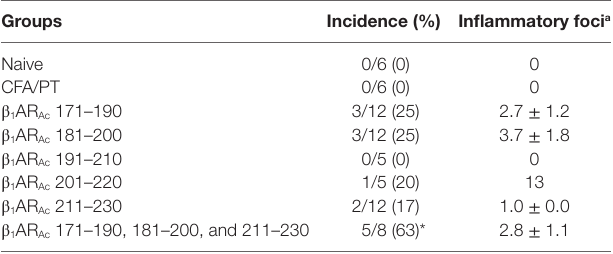
TaBle 1 | Induction of myocarditis by β 1 AR Ac